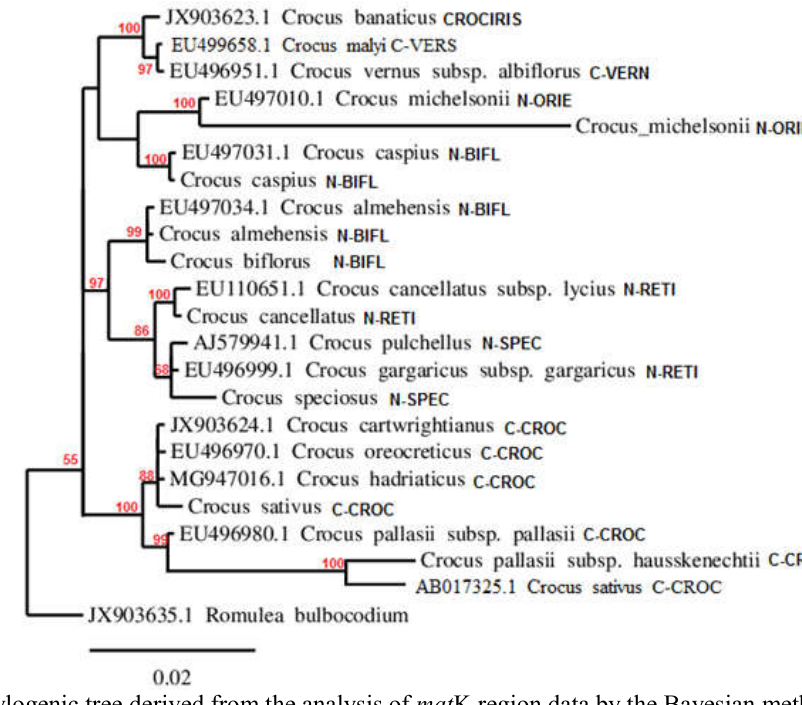
Fig. 2. The phylogenic tree derived from the analysis of mat K region data by the Bayesian method, the number above each branch shows the bootstrap value.